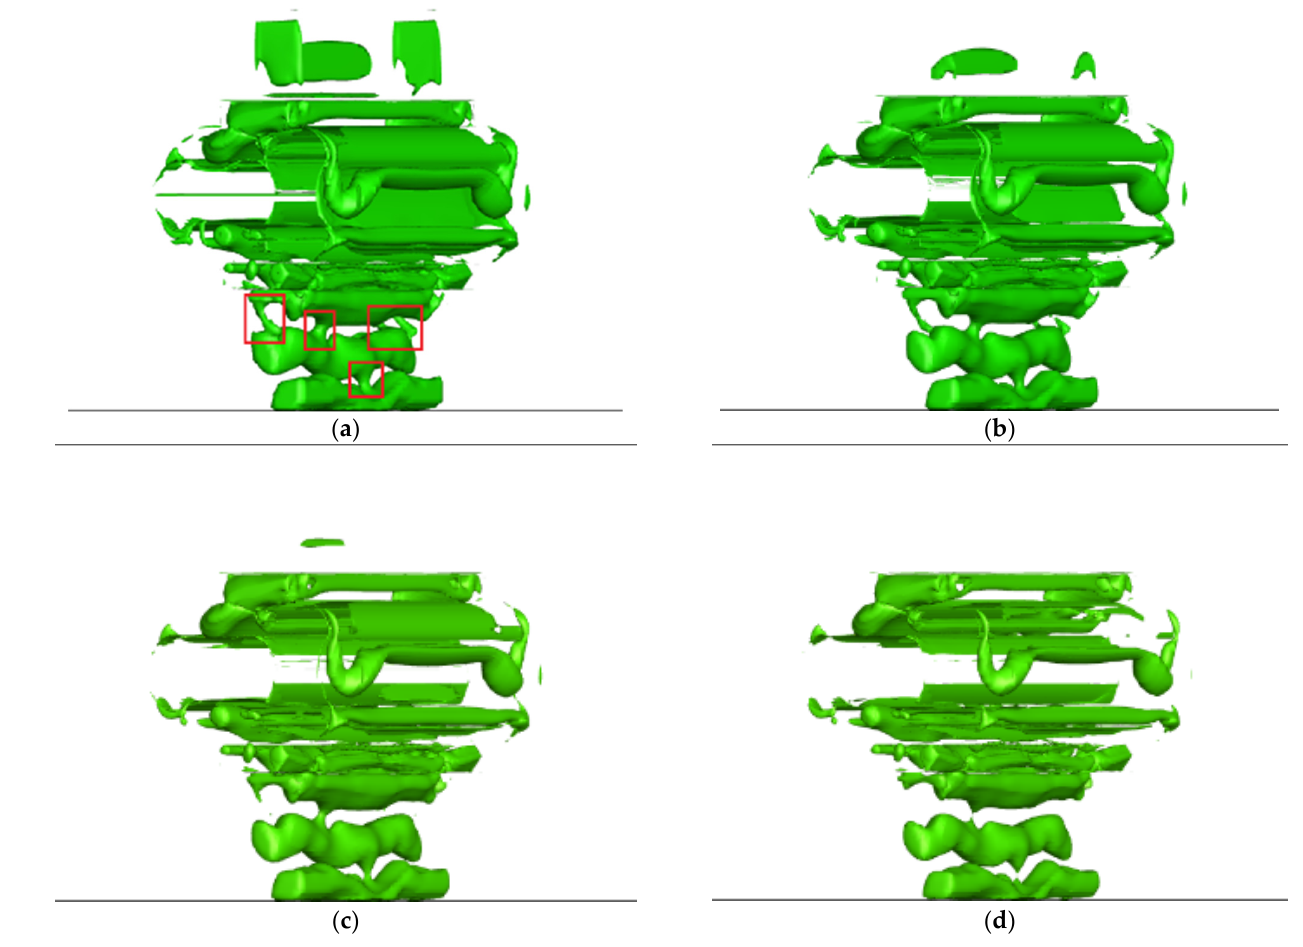
Figure 16. The Ω criterion vortex identification results of the Roots pump flow field at different thresholds: ( a ) Ω = 0.51; ( b ) Ω = 0.53; ( c ) Ω = 0.56; ( d ) Ω = 0.6.